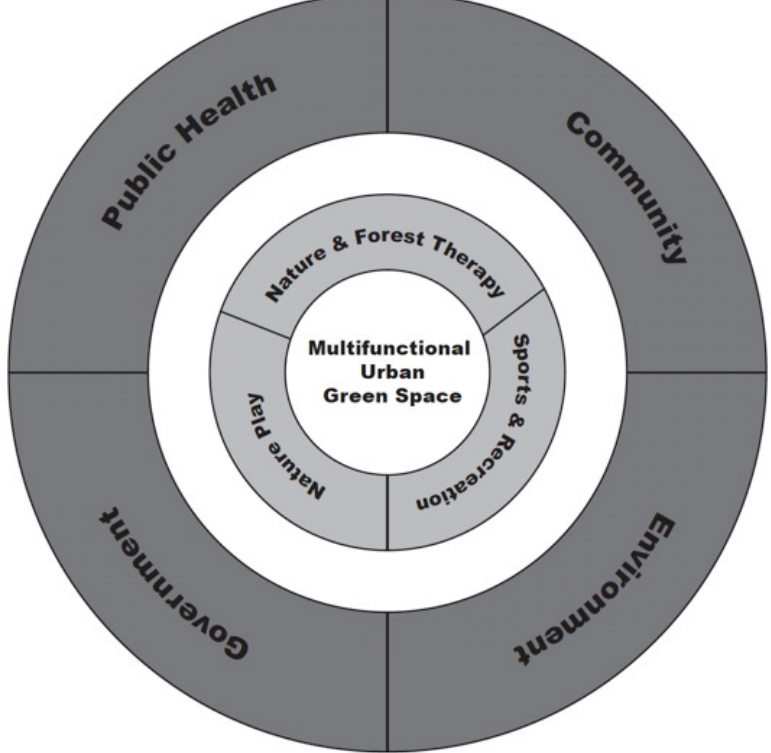
Figure 1. Proposed multidiscipline, multifunctional urban green space design framework.